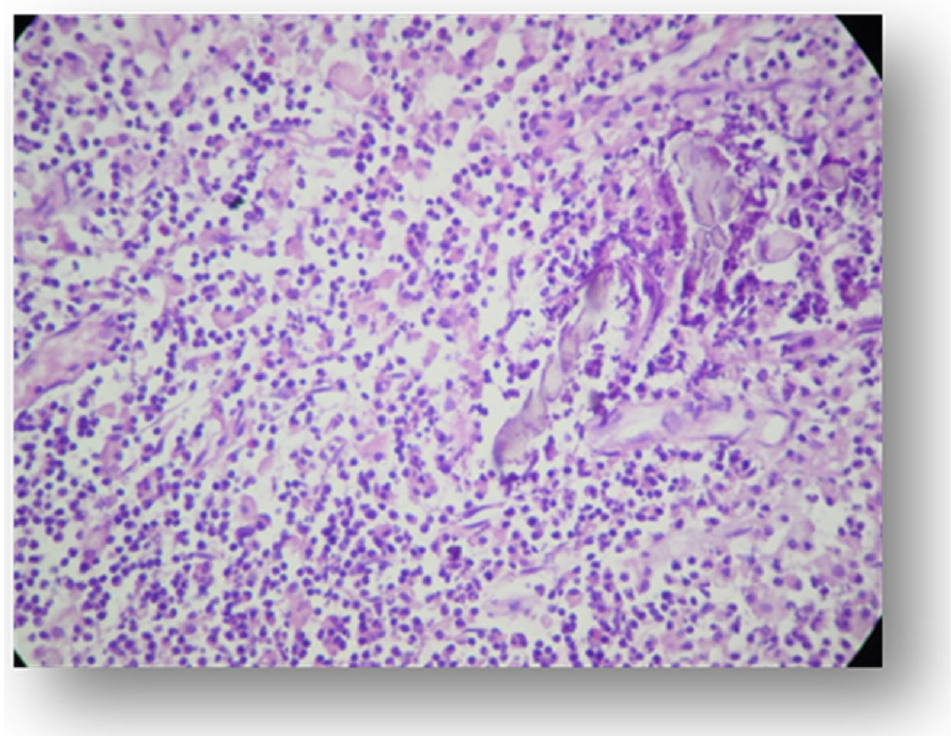
Figure 7. Coronal dental pulp aspect of a 65 year old man, type 2 diabetes HE staining, ×200.